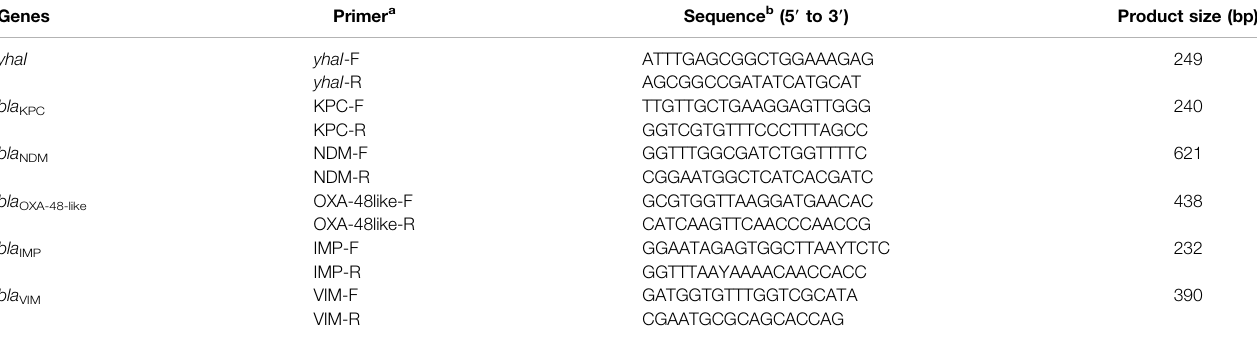
TABLE 2 | PCR primers for the K. pneumoniae inner membrane protein ( yhaI ) and carbapenemase genes ( bla KPC , bla NDM , bla OXA-48-like , bla IMP , and bla VIM ).